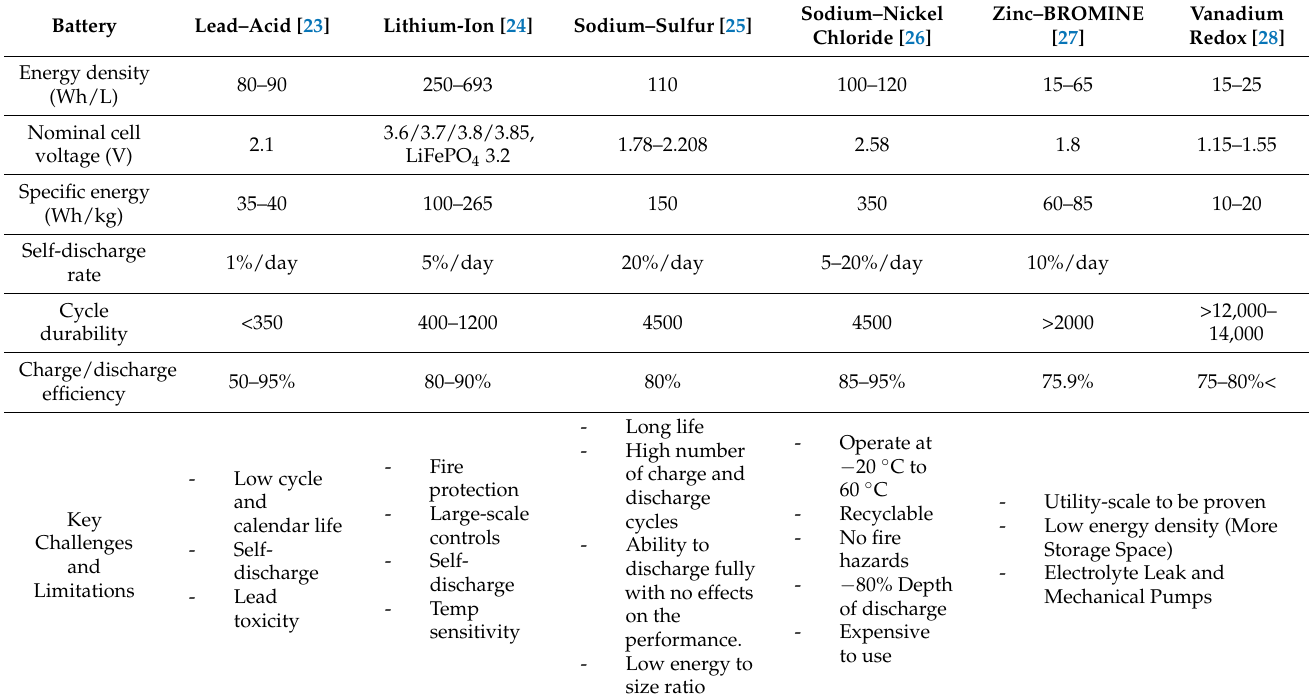
Table 2. Technical comparison of battery technology in South Africa